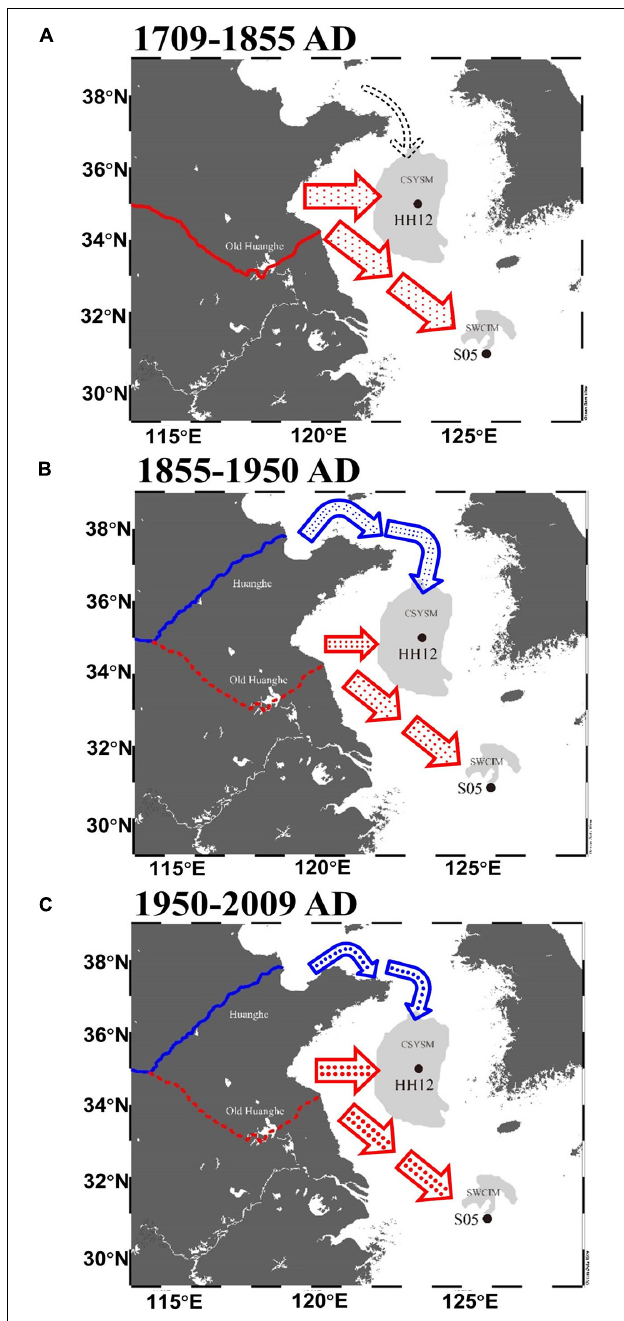
FIGURE 9 | Schematic diagram for Chinese river sourced terrigenous material transports during three-stage changes [ (A) 1709–1855 AD, (B) 1855–1950 AD, (C) 1950–2009 AD]. The arrows indicate transport pathways of terrigenous materials; the arrow size indicates the flux of terrigenous material transported; dots in the arrows represents grain size with larger dot indicating coarser sediment and vice